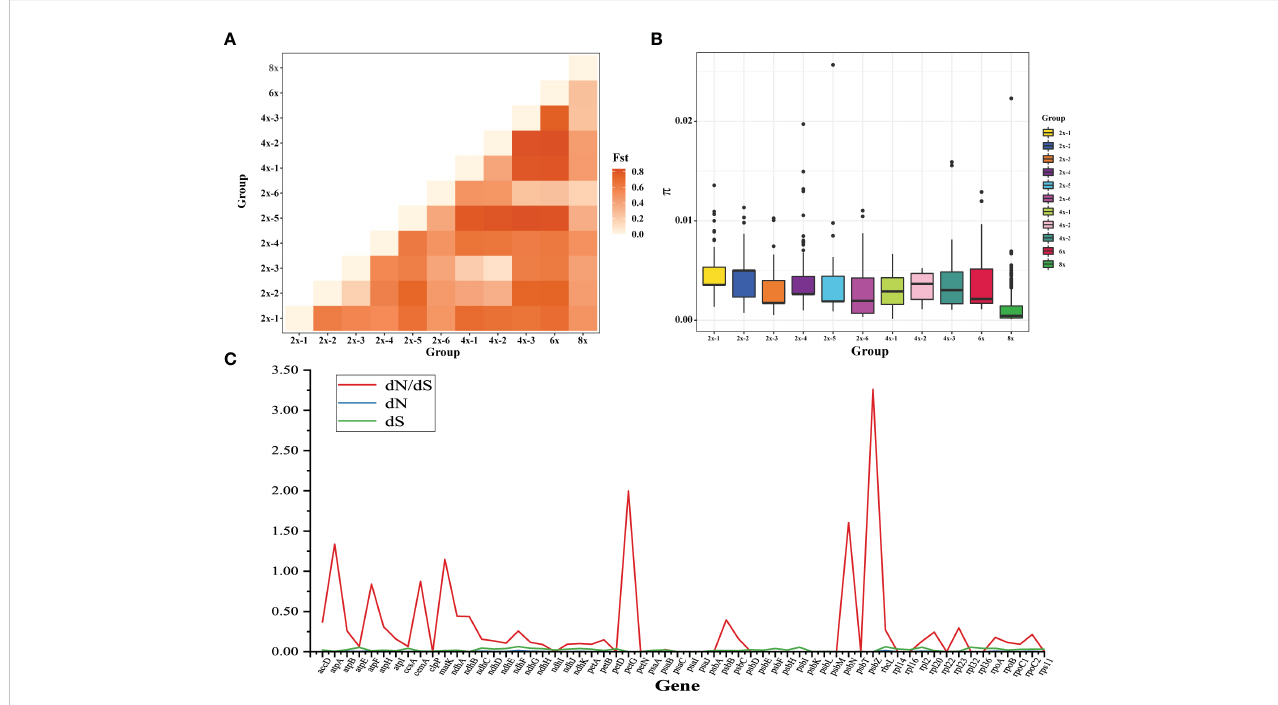
FIGURE 5 Analysis of Fragaria population genetic structure. (A) the pairwise Fst values between species of different ploidy levels; (B) Nucleotide diversity of chloroplast genome sequences of Fragaria species; (C) The estimations of the ratio of nonsynonymous to synonymous rates (dN/dS) of plastid protein- coding genes